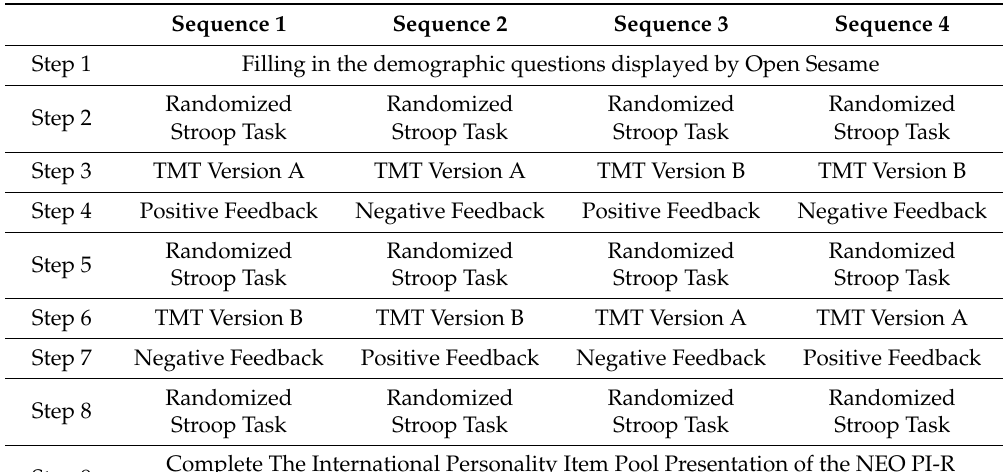
Table A1. Experiment order